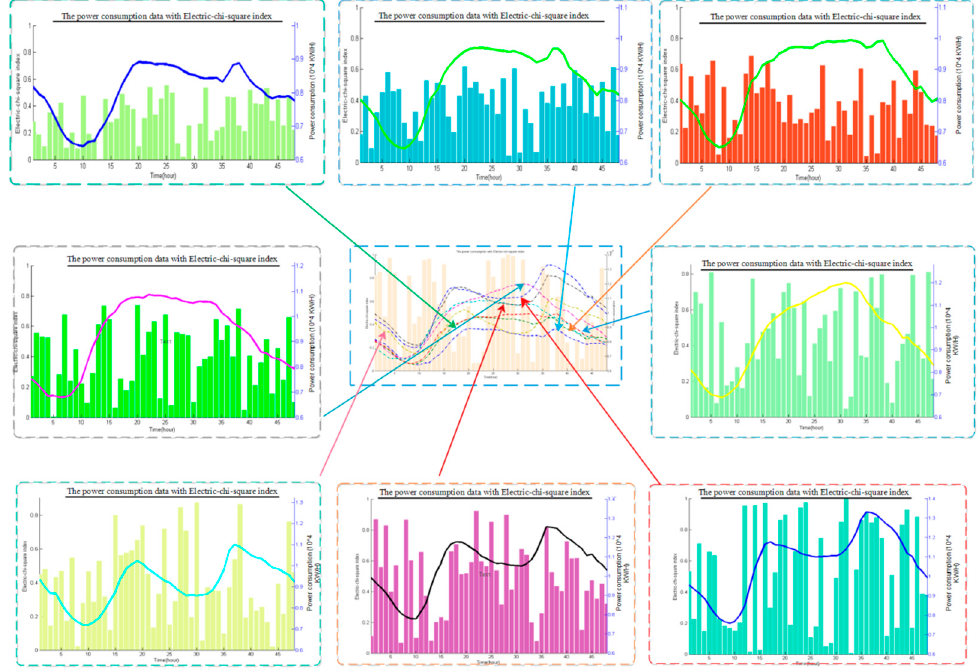
Figure 2. The general trend of data.